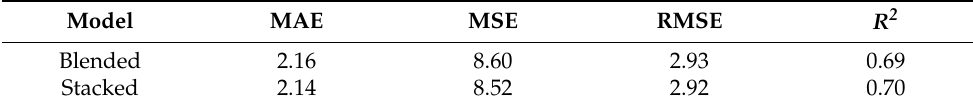
Table 7. Performance of blend and stack ensemble models.